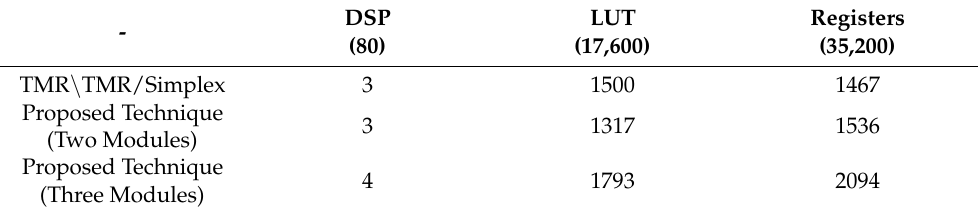
Table 3. Hardware resource comparisons.